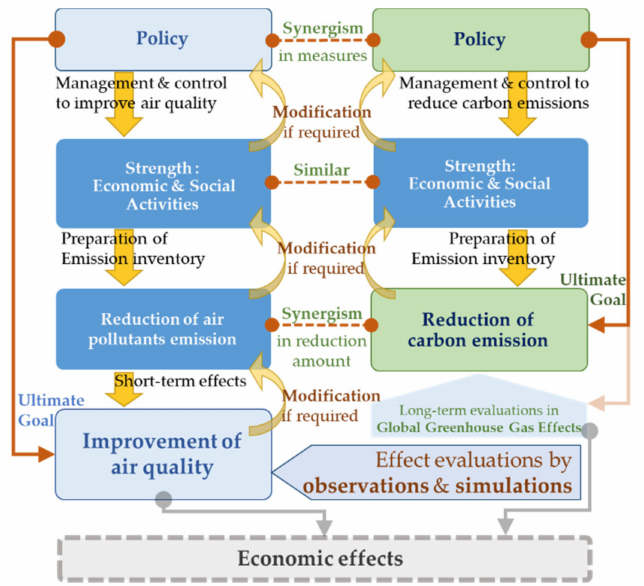
Figure 1. Relationship between improvement in air quality and reduction in carbon